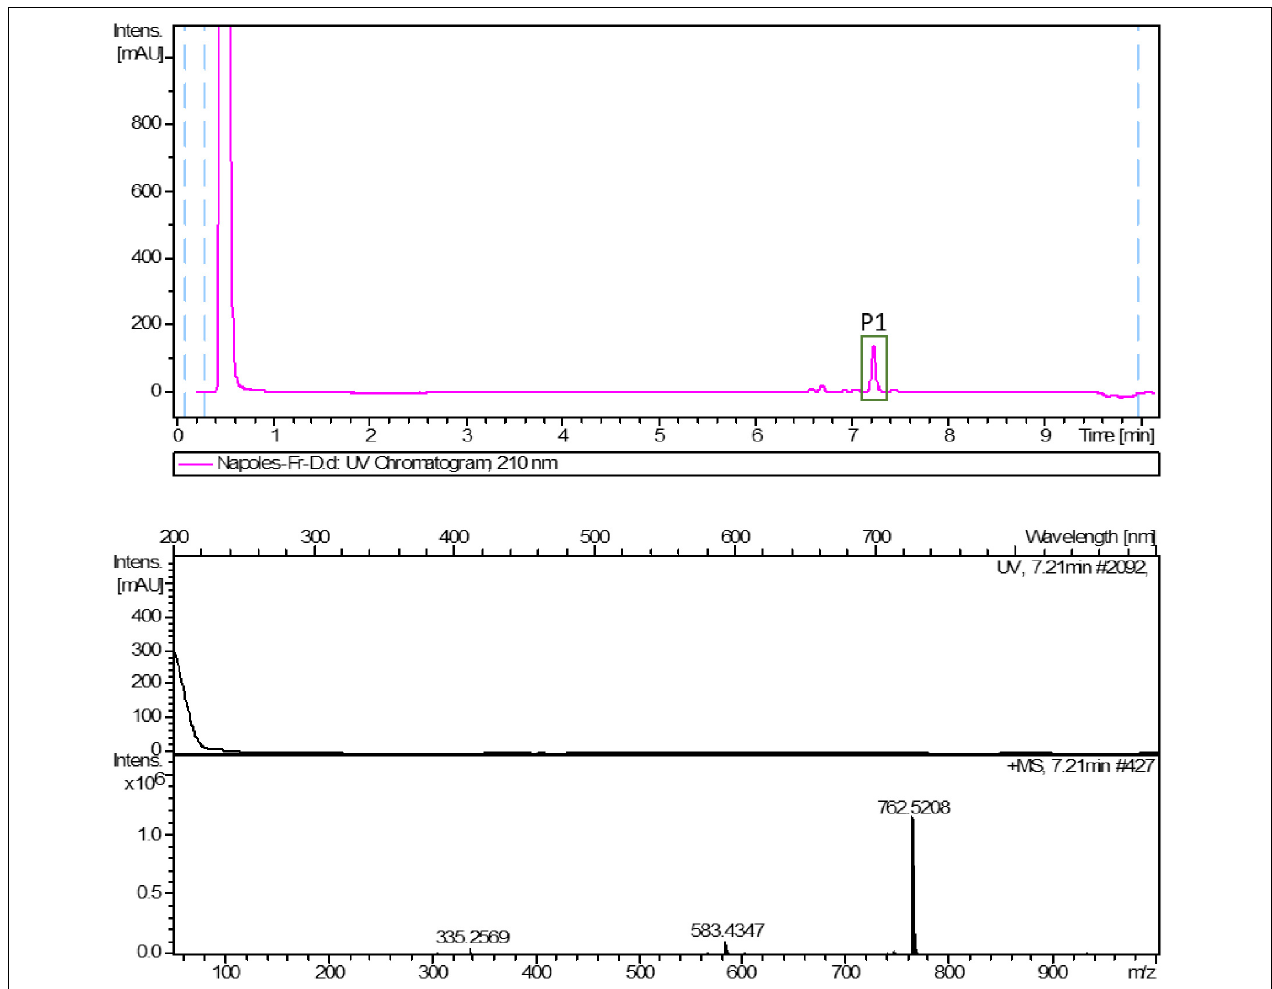
FIGURE 3 | LC-UV trace of fraction D from D. tertiolecta and UV and HRESIMS spectra of peak